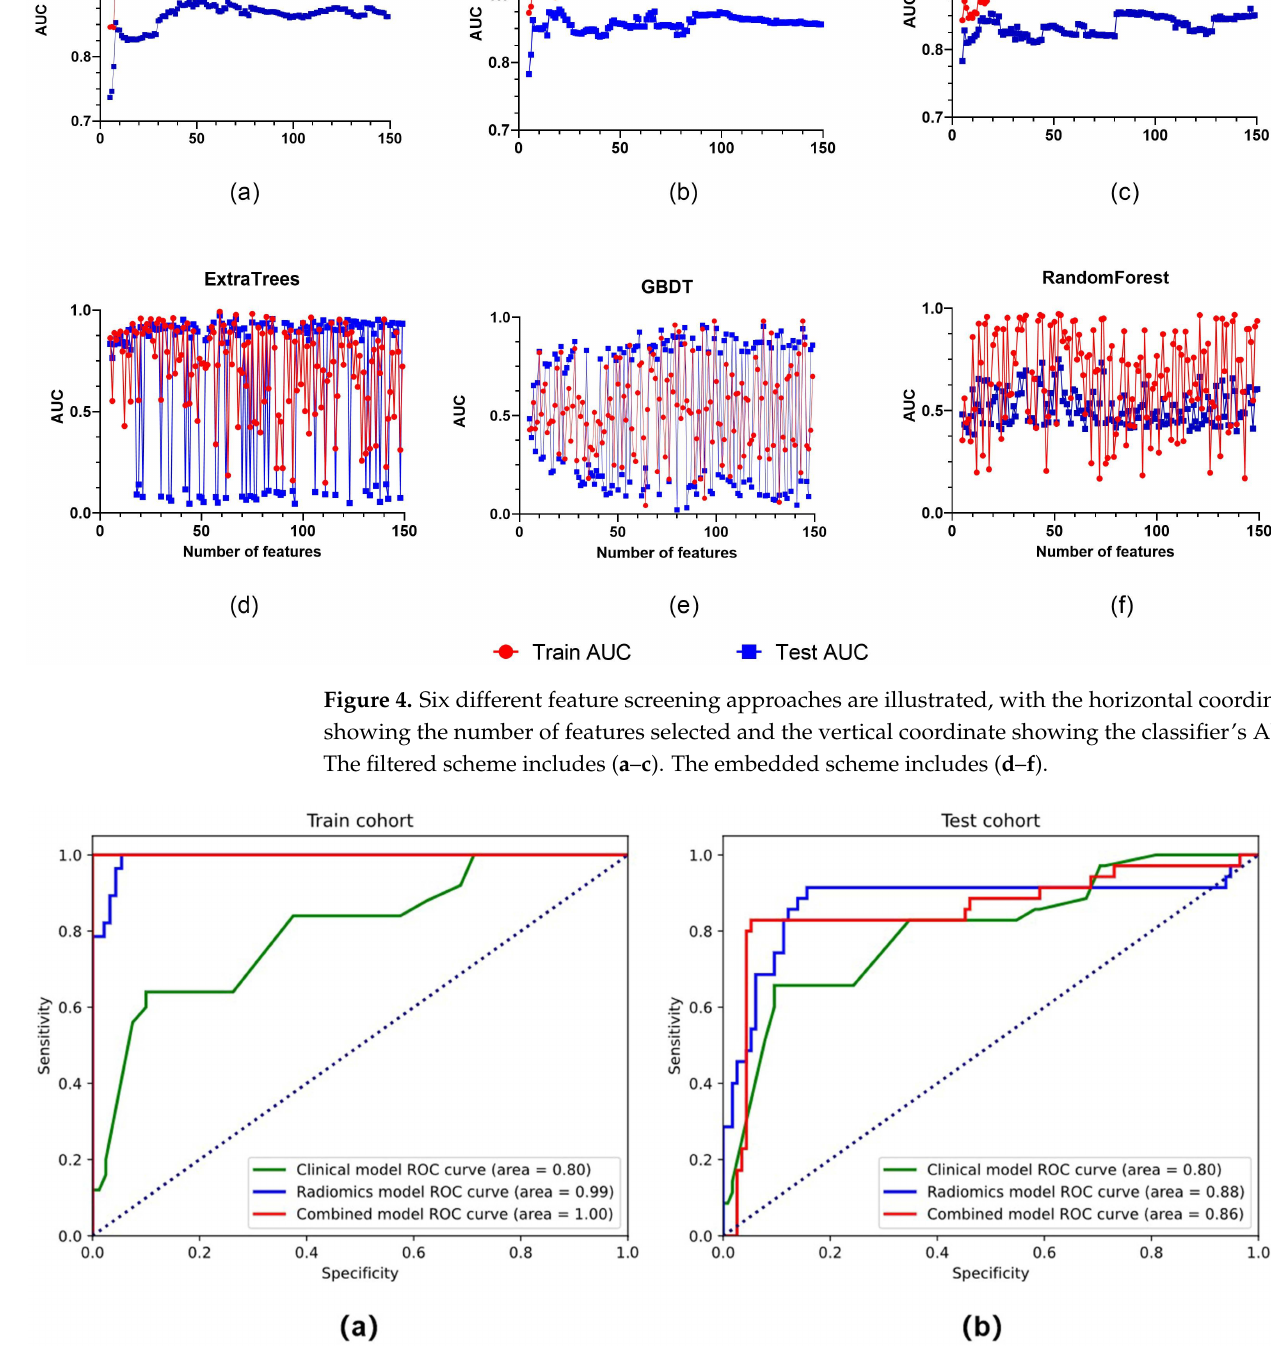
Figure 5. The ROC curves of the clinical model, radiomics models, and combined model in the training cohort ( a ) and testing cohort ( b